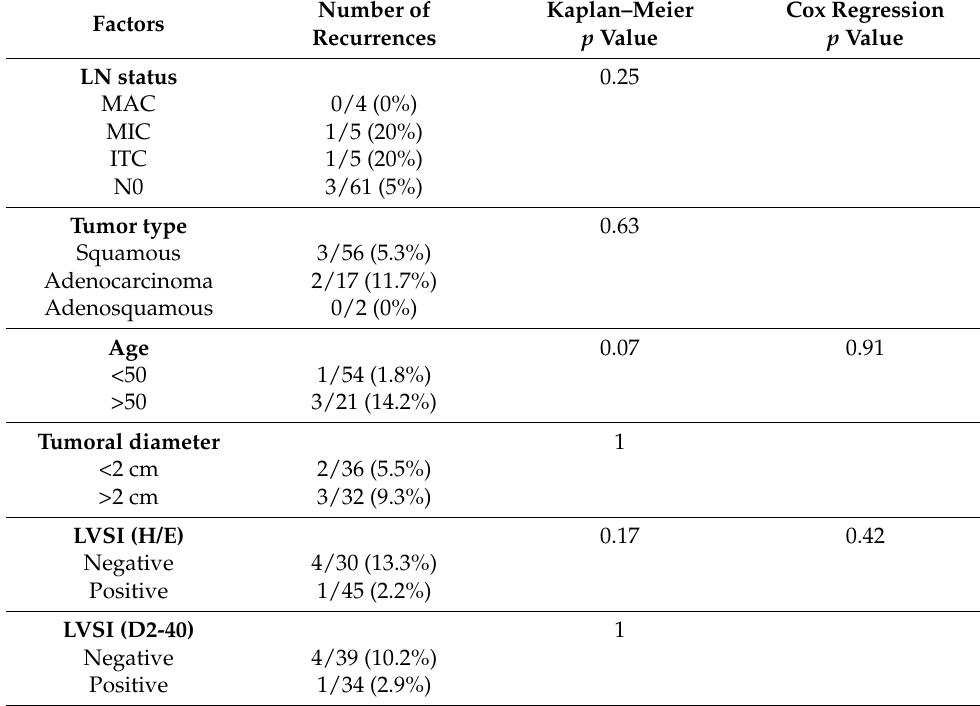
Table 5. Recurrence and risk factors.